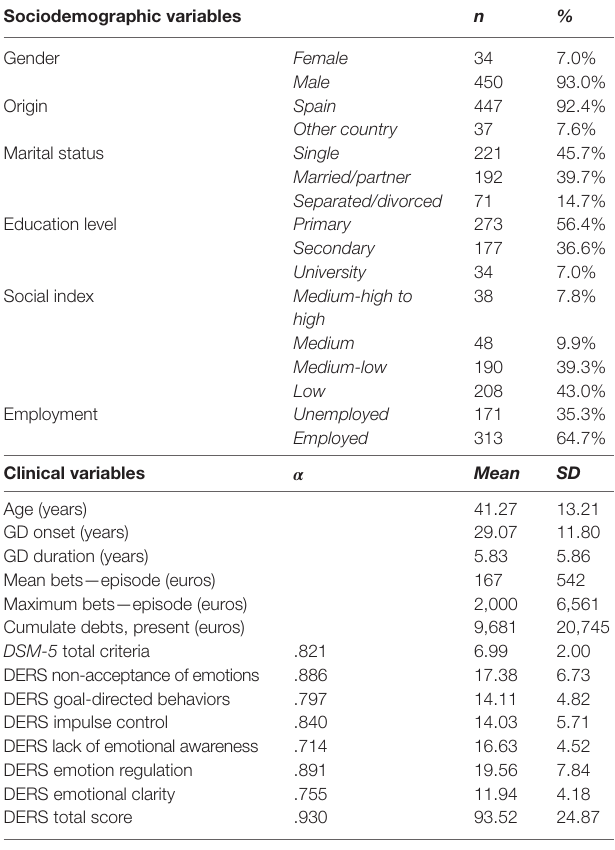
TABLE 1 | Sample description (n =